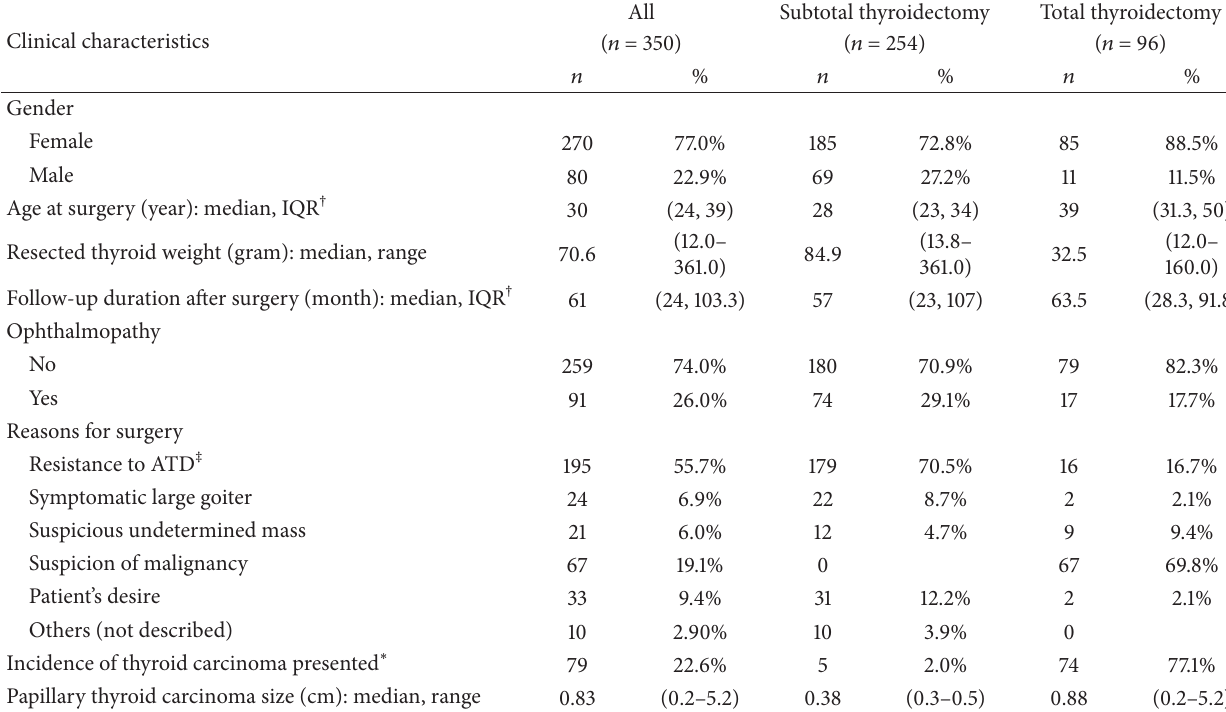
Table 1: Clinical characteristics of Graves’ disease patients who underwent surgery during the study period.